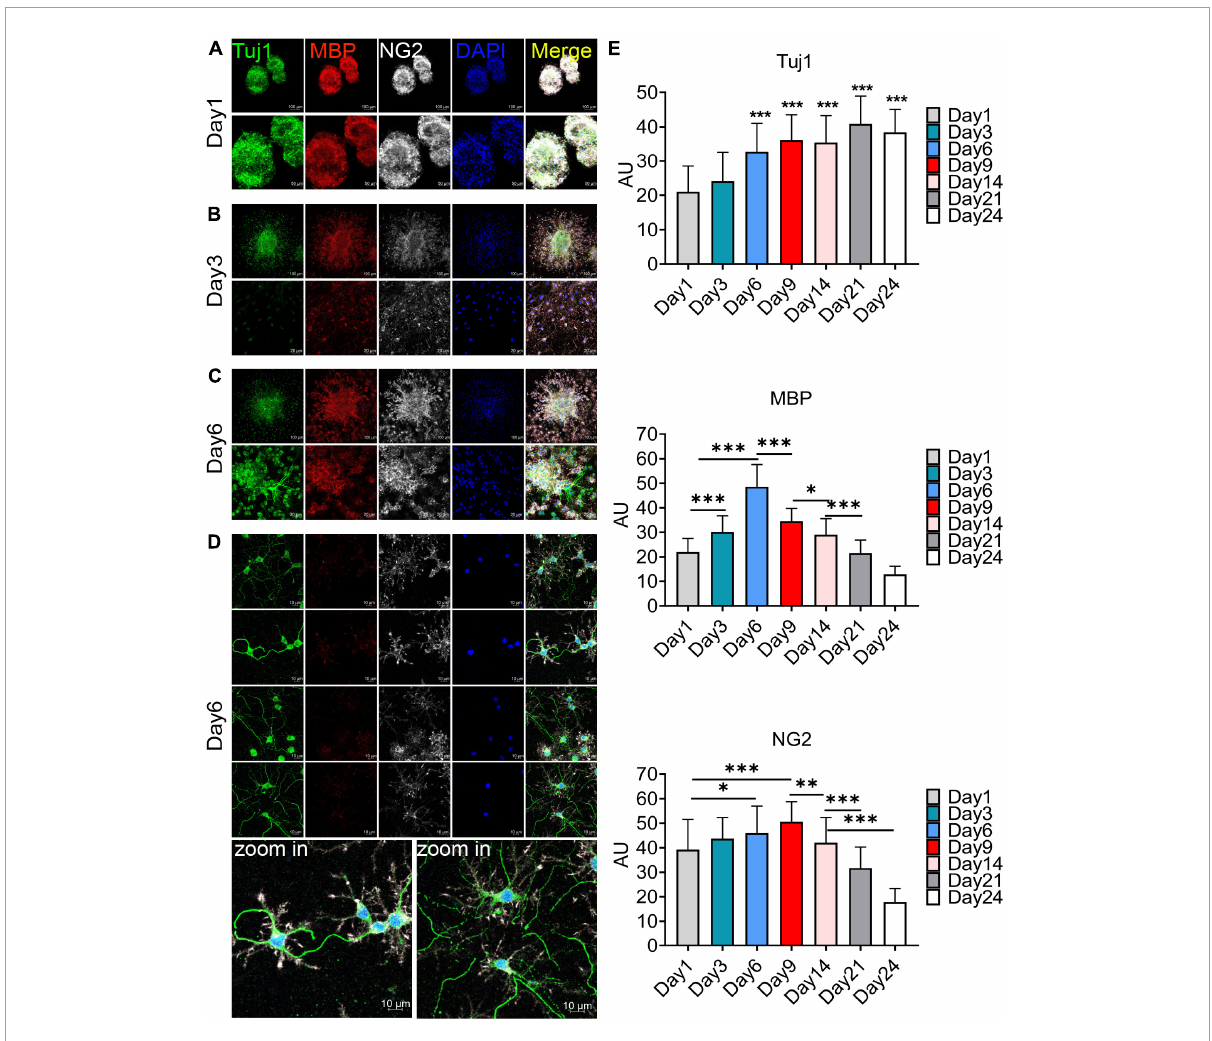
FIGURE3 Immunofluorescence staining to detect the cellular composition of oligospheres at different differentiation period. (A–D) F4 generation oligospheres were used for immunofluorescence staining to detect the cellular composition of oligospheres at different time with Tuj1 (green), MBP (red), and NG2 (white). n = 3 biological repeats. Scale bars are indicated in the pictures. (E) The histograms showed the statistical results of fluorescence intensity. Values are the mean ± SEM. Statistical significance was determined by one-way ANOVA followed by Student Newman–Keuls post-hoc test. ∗ P < 0.05, ∗∗ P < 0.01, ∗∗∗ P < 0.001. n = 3 biological repeats. Scale bars had been indicated in